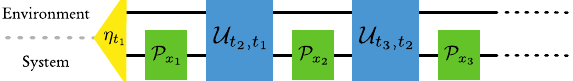
properties of the intermediate evolutions U initial state η se